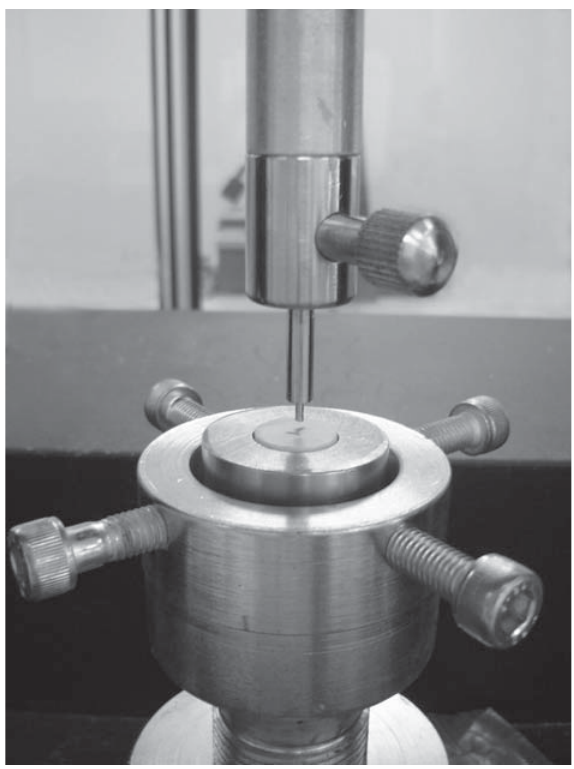
Figure 2- Specimen during testing in the universal